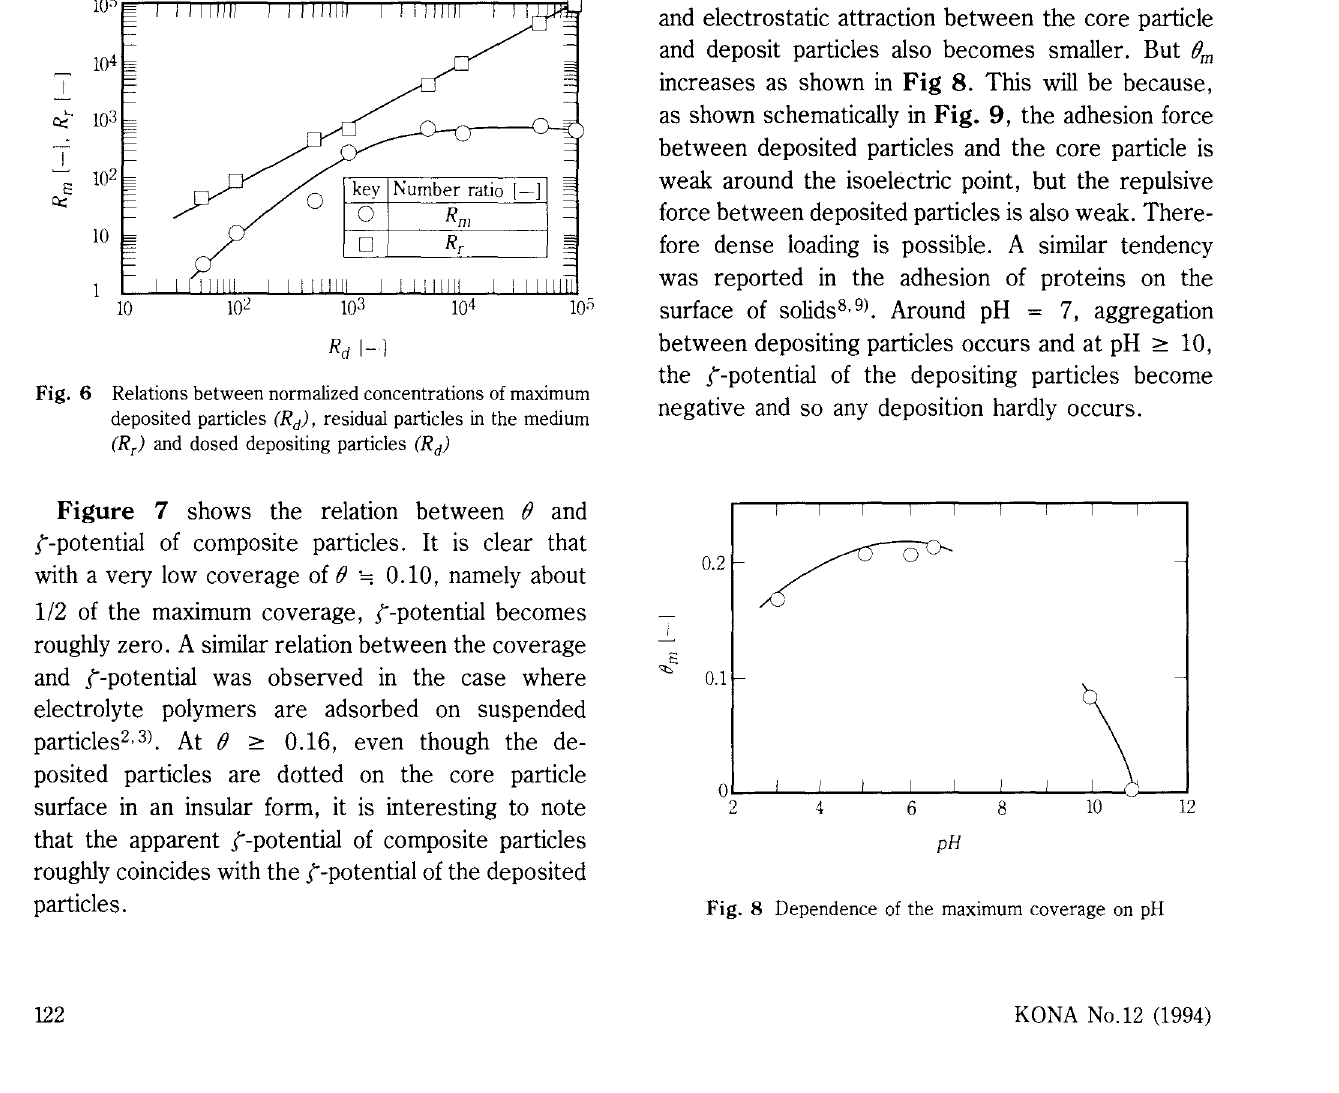
Fig. 8 Dependence of the maximum coverage on